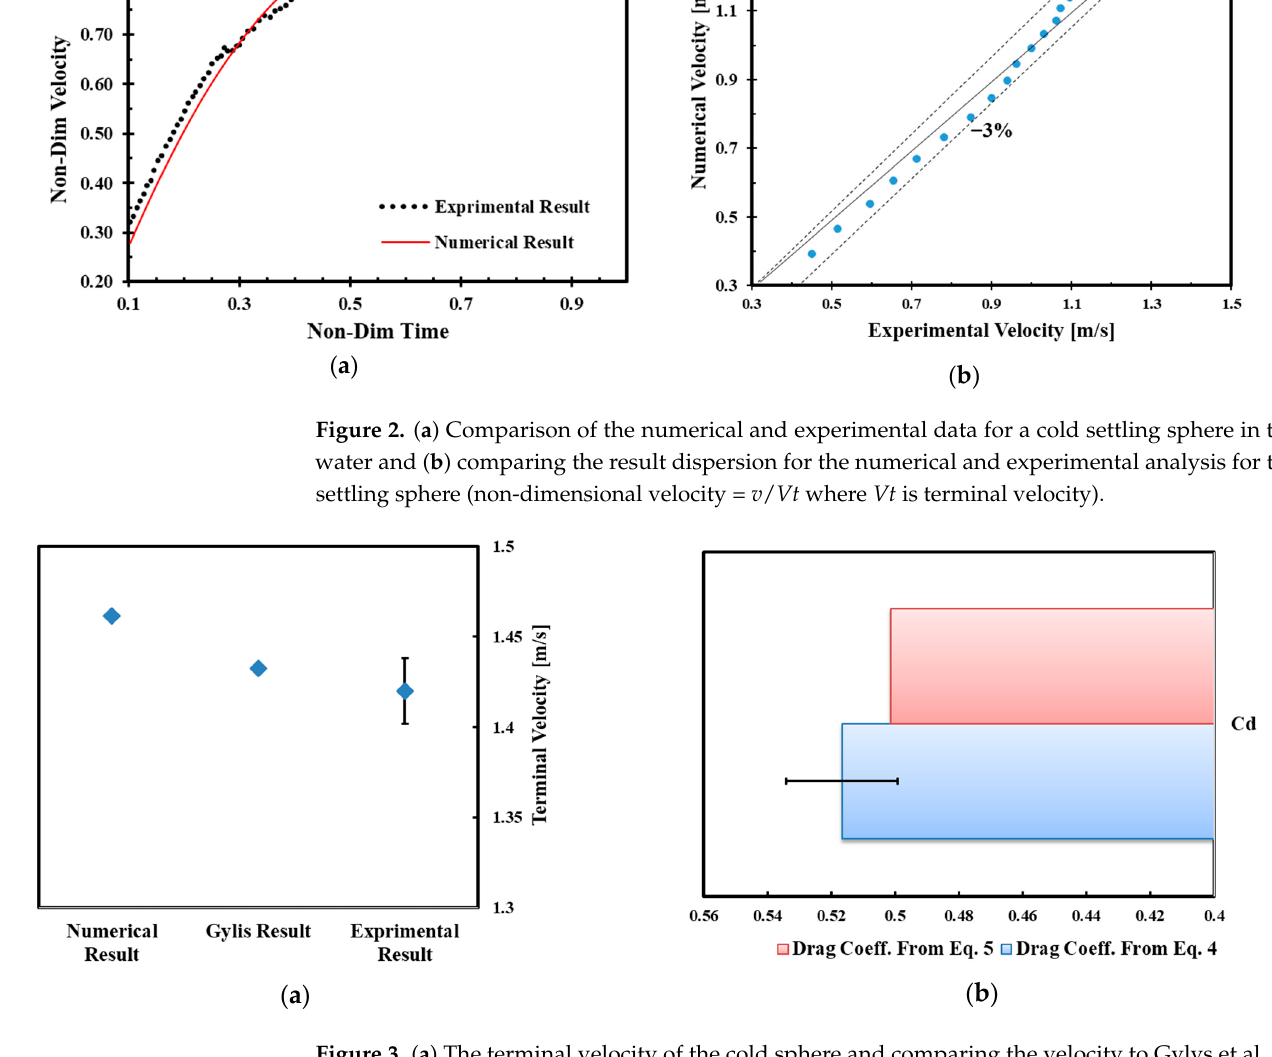
Figure 2. ( a ) Comparison of the numerical and experimental data for a cold settling sphere in the water and ( b ) comparing the result dispersion for the numerical and experimental analysis for the settling sphere (non-dimensional velocity = v / Vt where Vt is terminal velocity).